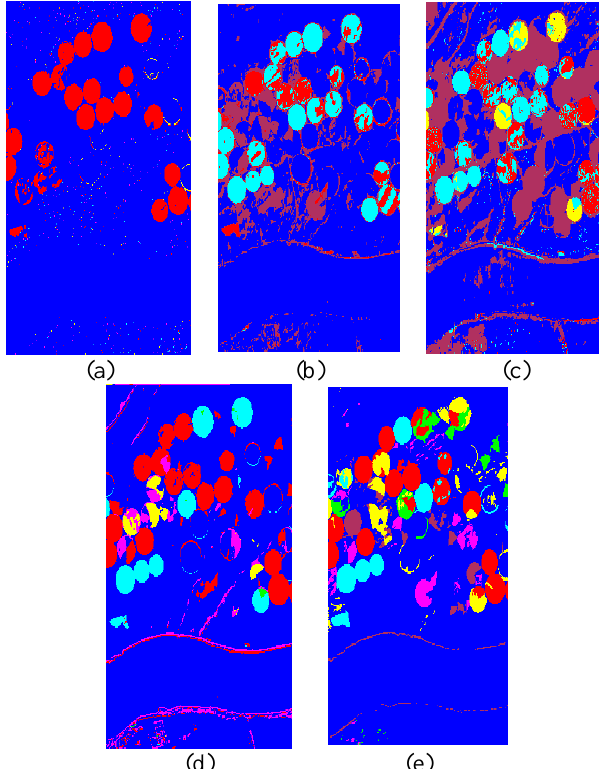
Figure 4. The result of multiple change maps detected by different endmember extraction algorithms for USA data set. (a) SISAL, (b) N-FINDR, (c) VCA, (d) FUN, and (e) multiple change map ground truth.